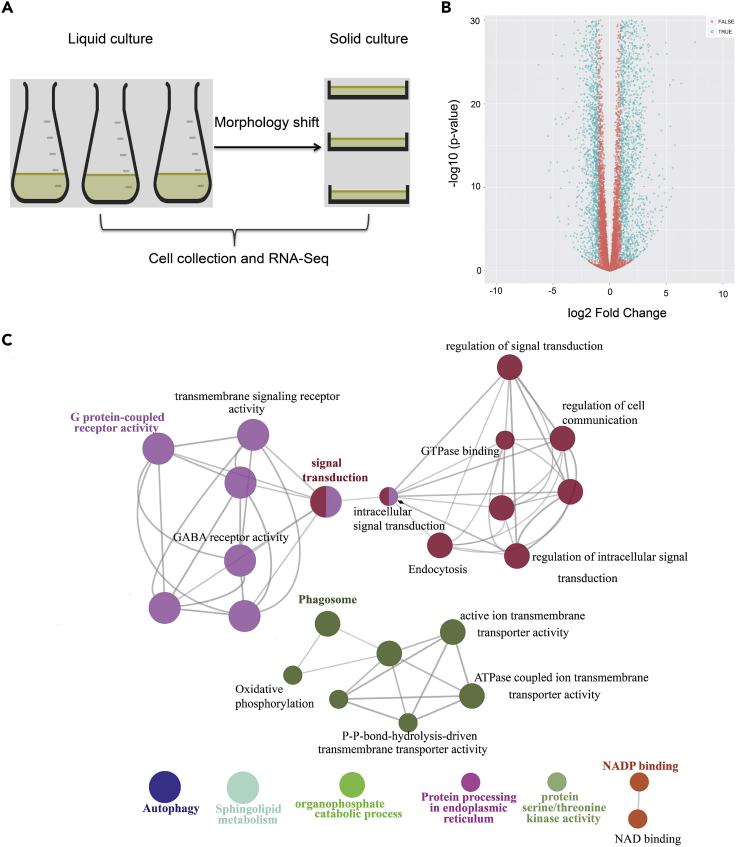
Global Transcriptomic Analysis and Identification of DEGsFor a Figure360 author presentation of this figure, see https://doi.org/10.1016/j.isci.2020.101424.(A) Liquid culture (fusiform cells in population >90%) and solid culture (oval cells in population >75%) of the model diatom P. tricornutum Pt1 8.6F were generated and cells were collected for RNA-seq.(B) Volcano plot with p values and fold changes as log-scaled axes. DEGs are identified with a threshold of log2(fold changes) > 1 and a significance level of FDR < 0.05. Significant differences at p value < 0.05 with >2-fold changes are shown in blue color.(C) Gene set enrichment analysis of up-regulated signaling genes highlighting the GPCR signaling pathway. A group of 61 identified signaling genes was used for analysis. GO terms are represented as nodes in the graph, each pathway and its related nodes were presented with a unique color (p < 0.05), and node sizes indicate the relative numbers of genes that represent the GO term, whereas the edges represent genes shared between the GO terms.